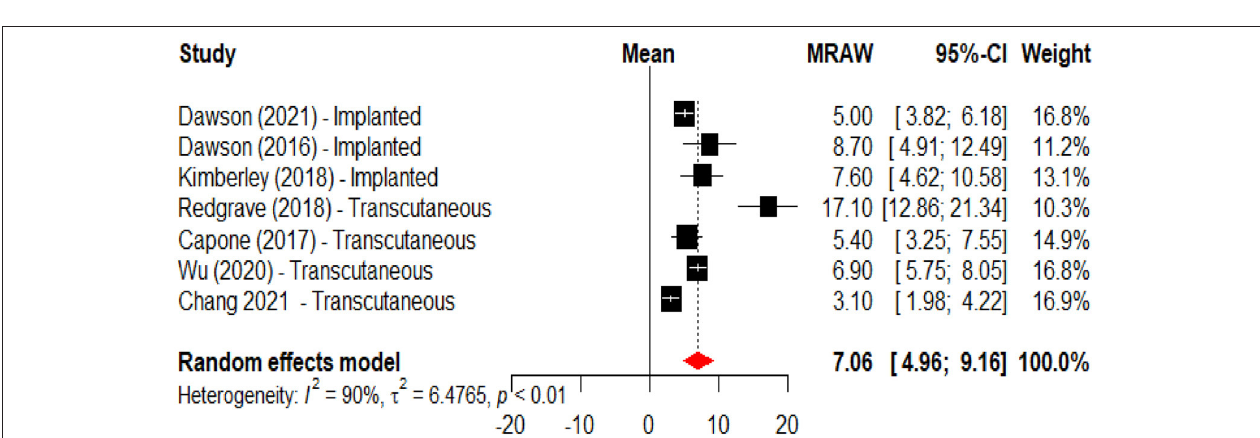
FIGURE 3 | Forest plot for the meta-analysis of vagus nerve stimulation effects on upper limb motor function (FMA-UE score increase) when compared to baseline. Dawson et al. (34), Dawson et al. (47), and Kimberley et al. (47) used implanted VNS, Capone et al. (46), Redgrave et al. (45), Wu et al. (43), and Chang et al. (44) used transcutaneous